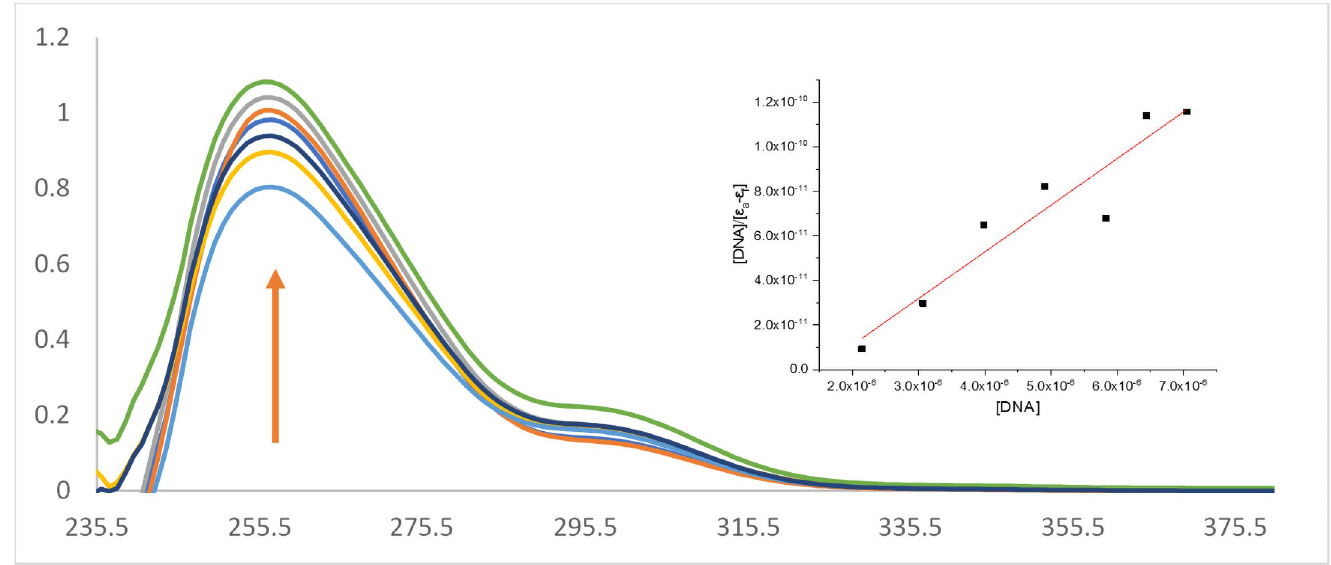
Fig 7. The hyperchromic reactions of [(UO 2 )(OAc) 2 (SCZ)] (arrow indicates changes with increasing DNA concentration).